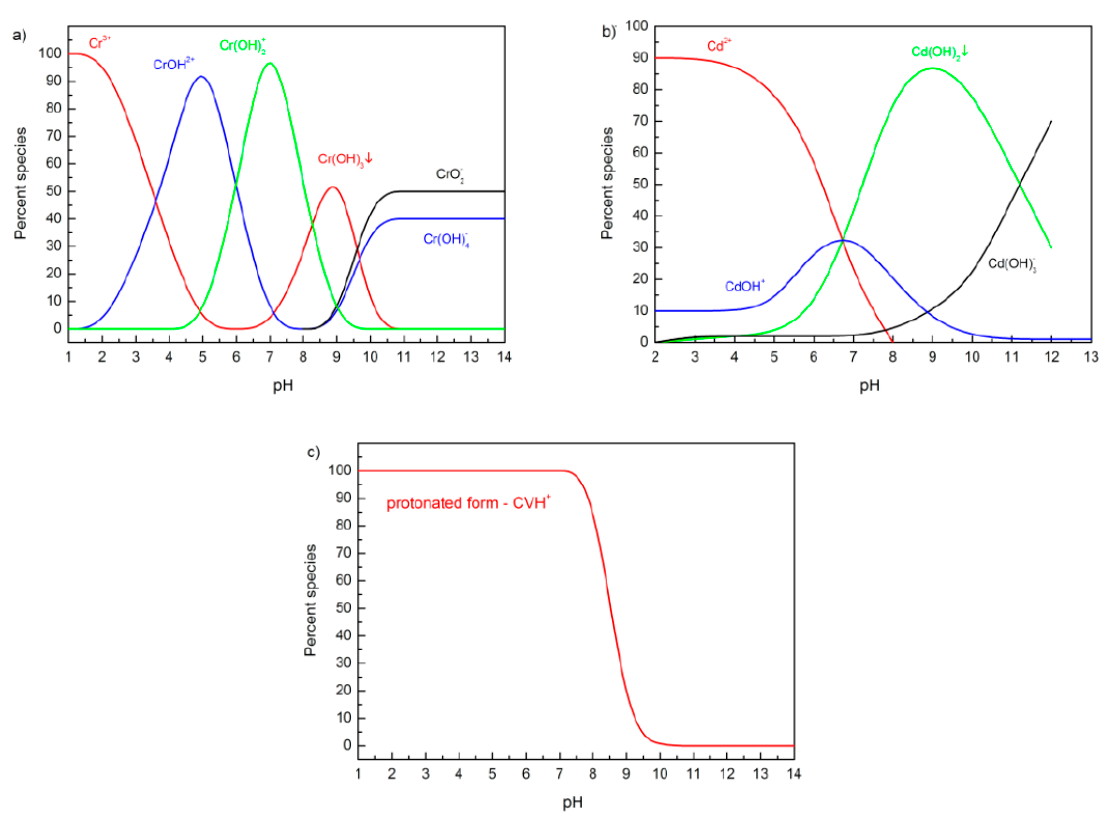
Figure 6. Distribution of the prevalent species of ( a ) chromium, ( b ) cadmium and ( c ) crystal violet in aqueous solution as a function of pH. The calculations were carried out using Visual Minteq ver. 3.0 (software of Jon Petter Gustafsson, KTH, Sweden).